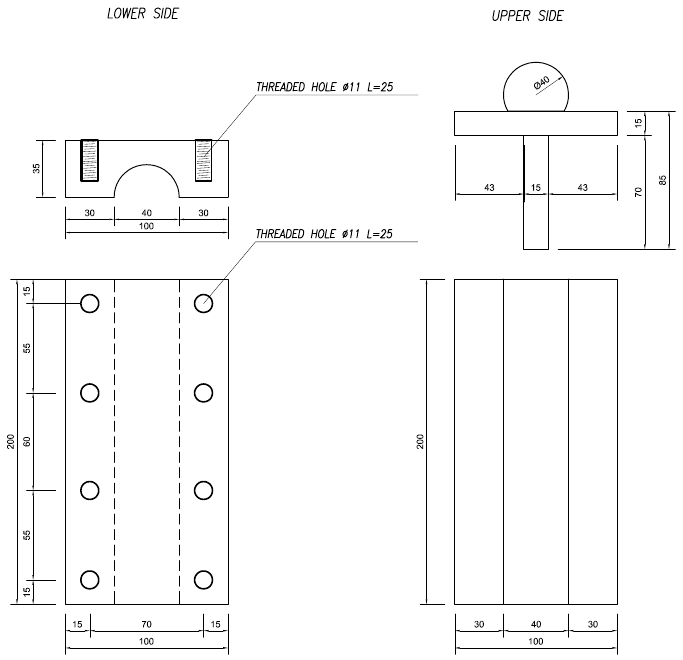
Figure 3. Graphical illustrations of the beam supports (unit: mm).